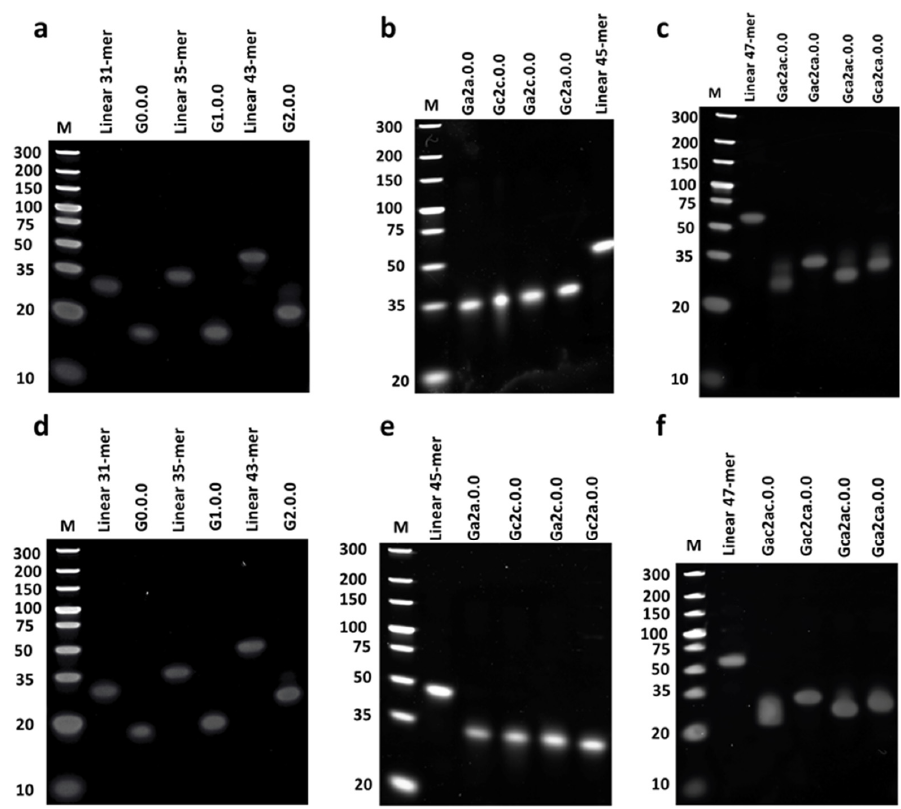
Figure 6. Polyacrylamide gel electrophoresis of G ‐ quadruplex CpG ODNs. Samples were reconstructed in ( a – c ) D ‐ PBS buffer (containing 4 mM K + 150 mM Na + ) and ( d – f ) Tris ‐ HCl buffer by structed in ( a – c ) D-PBS buffer (containing 4 mM K + 150 mM Na + ) and ( d – f ) Tris-HCl buffer